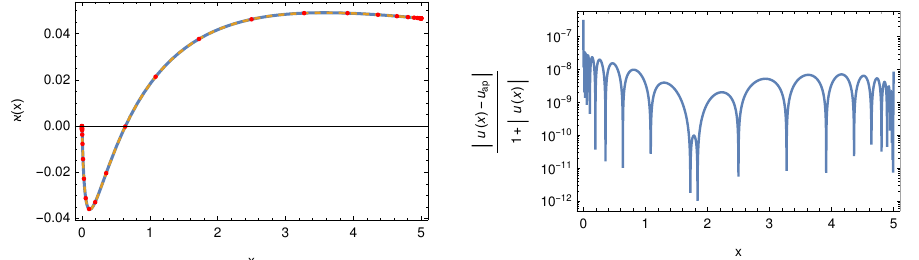
Figure 11. A true ℵ function using a Mellin representation Γ ( 1 + 2 s ) / ( 1 + 2 Γ ( s )) approximated with N = 24 Sinc points (left panel). The right panel shows the local relative error where u ( x ) is given by a Sinc approximation with N = 128.